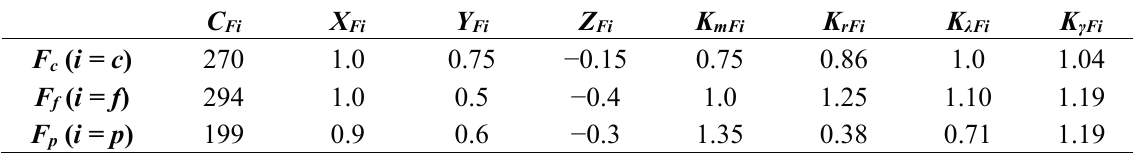
Table 3. Cutting force coefficients for the mechanistic-empirical